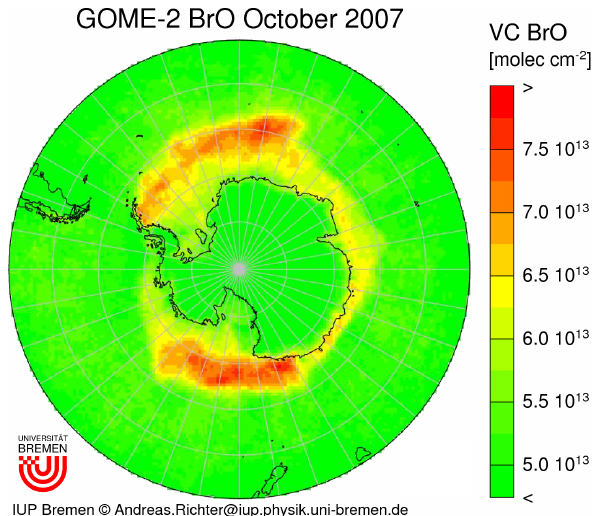
Fig. 2. An example of higher BrO concentrations (in red) observed each year around the Antarctic continent during springtime. This monthly average map shows total BrO retrieved from measurements of the GOME-2 instrument in October 2007. The columns include both the stratospheric contribution (about 5 × 10E 13 moleccm − 2 ) and the tropospheric BrO amounts. (Richter et al.,